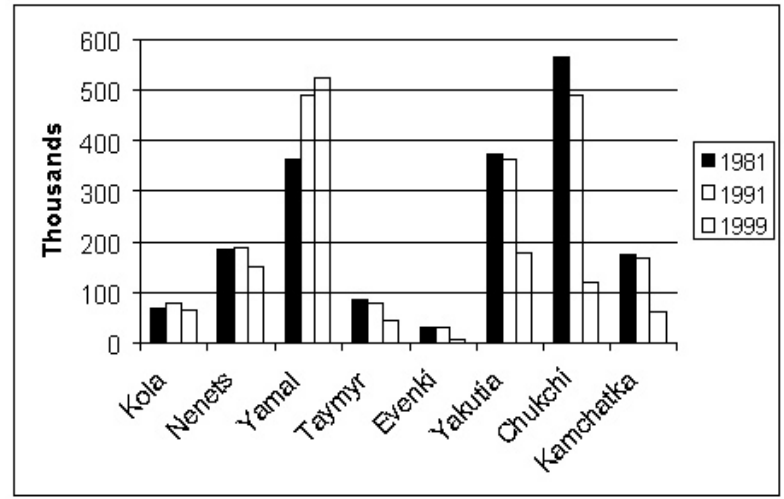
Fig. 3. Tame reindeer numbers in regions of the Russian Federation (Baskin, 1989; Syroechkovsky,